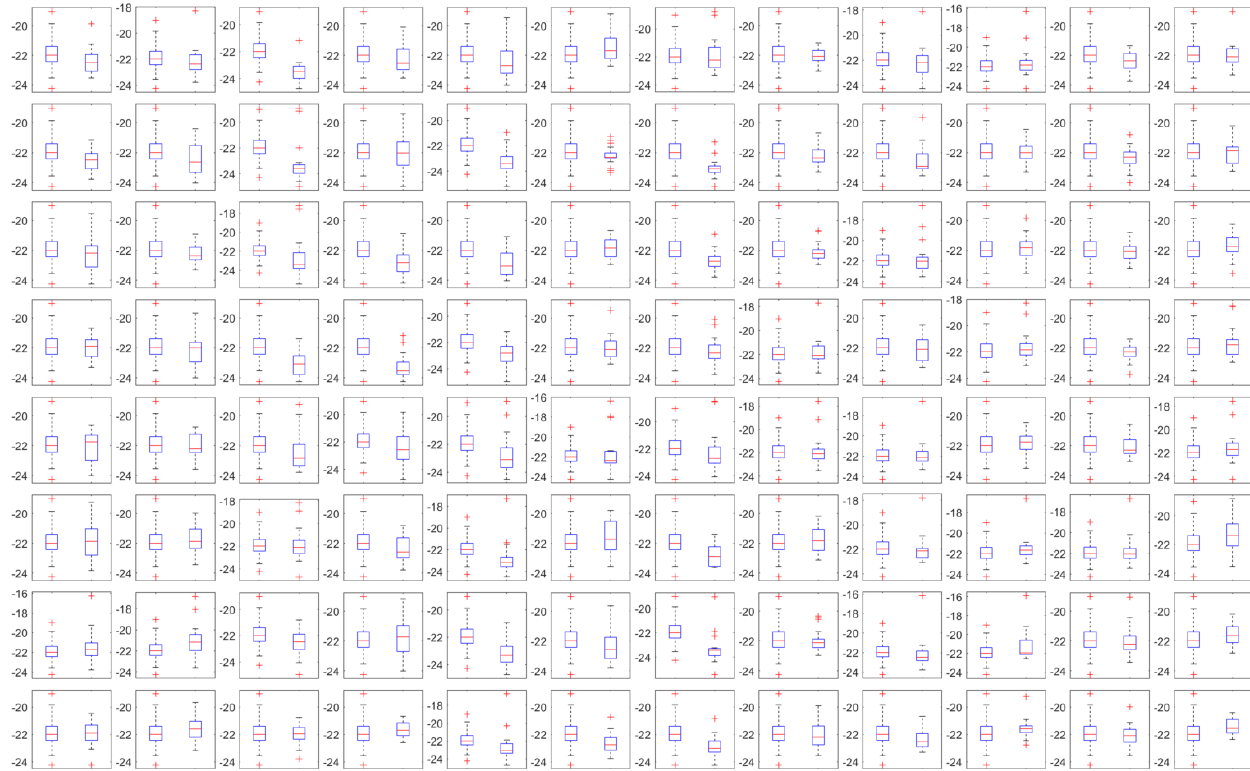
Figure A2. A side-by-side comparison of box plots for the freezing temperatures of the 20 SA water experiments of the reference wells (left box) and the well represented by the location (right box) of each subplot. The median is shown as a red line, the interquartile range is depicted by the blue box, extreme values not considered outliers (whiskers) and outliers (red crosses) are shown as a function of temperature (in ◦ C; y